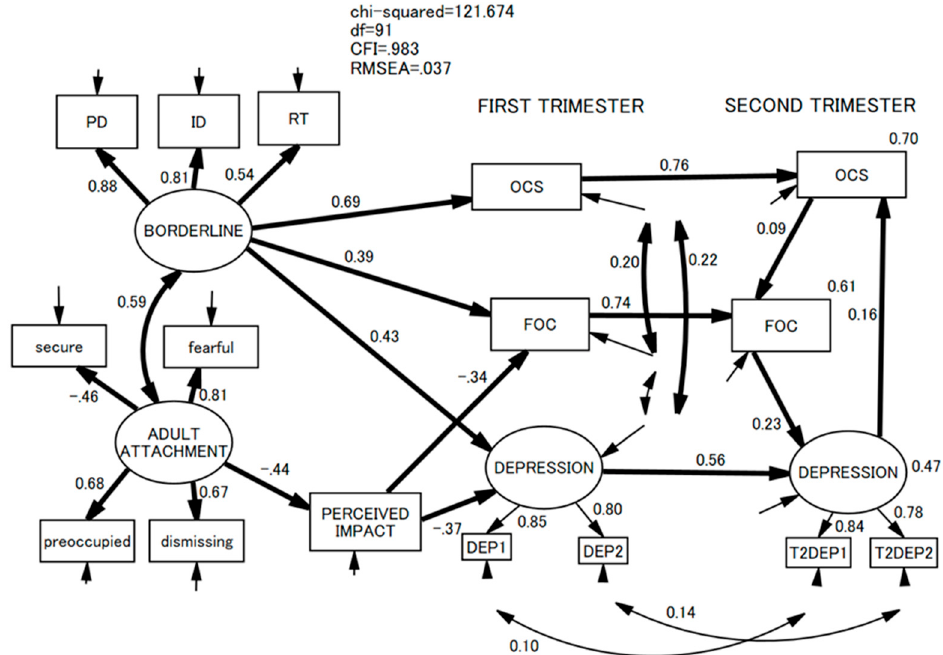
Figure 2. Final model after trimming.